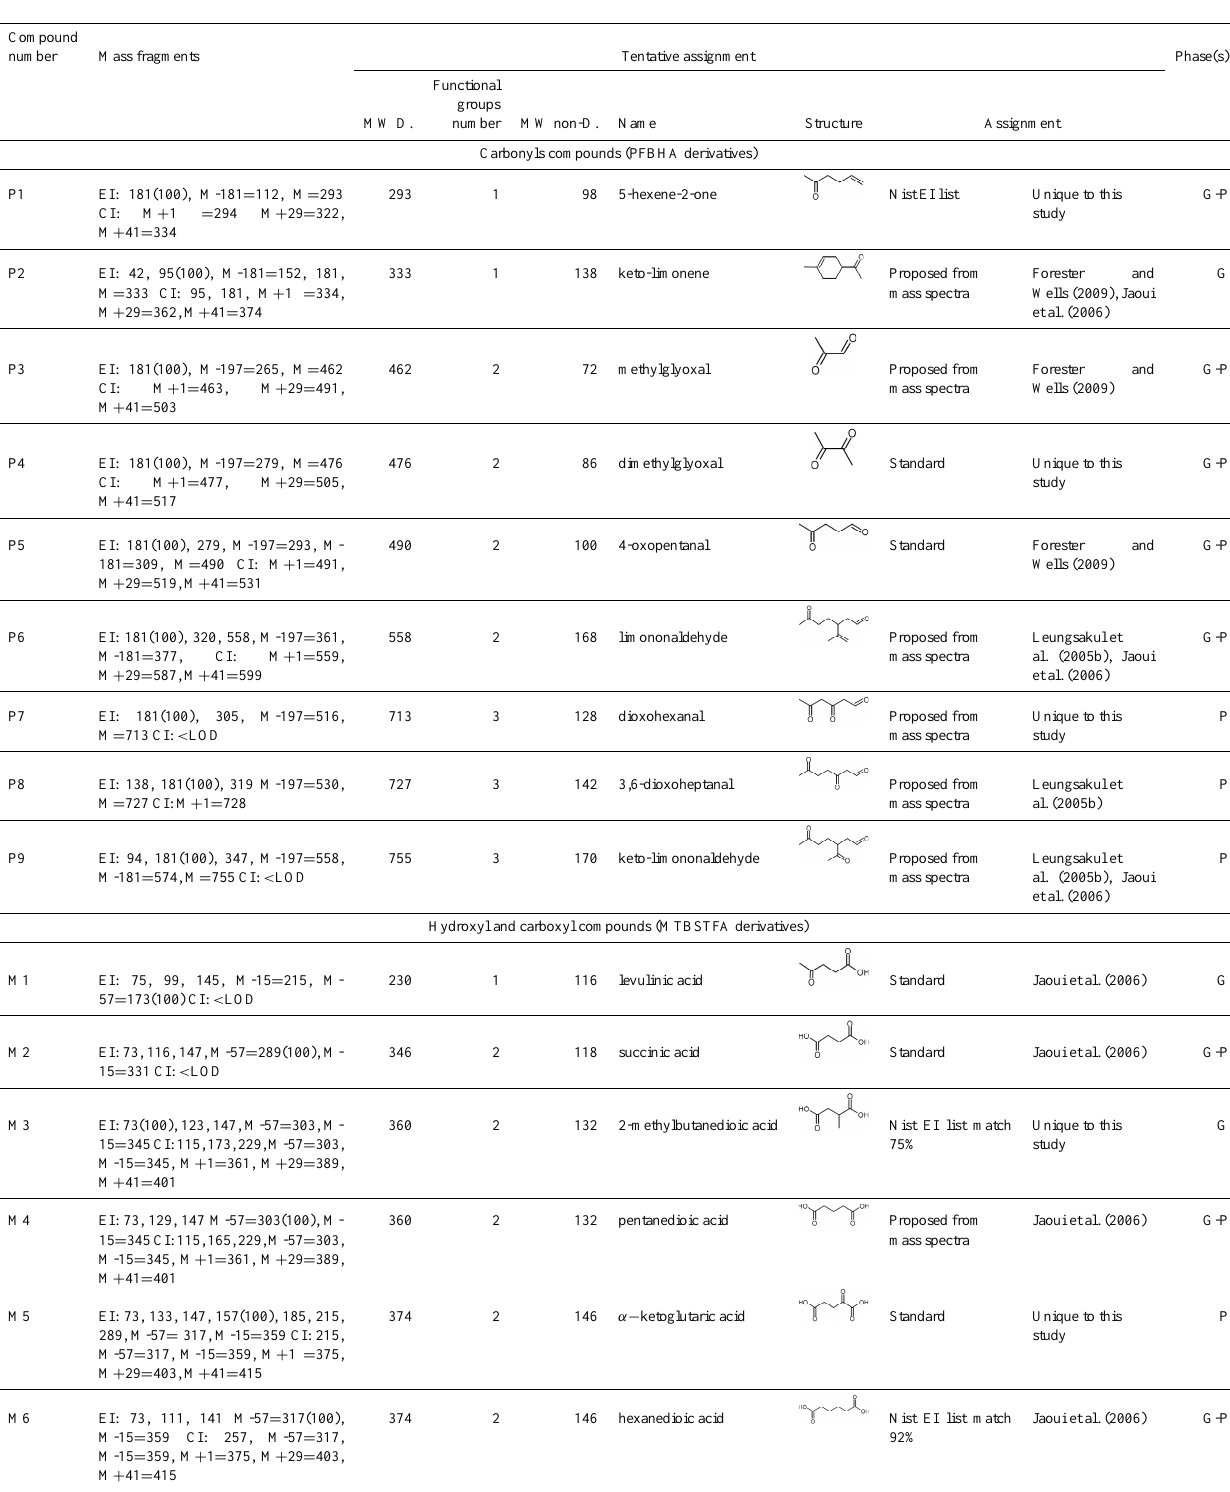
Table 7. Tentative or positive identification for observed carbonyl compounds, organic acids and hydroxyls compounds from limonene ozonolysis experiment. MW D.: molecular weight of the derivatised compound. MW non-D.: molecular weight of the non-derivatised compound. LOD: limit of detection. G: detected in the gas phase. P: detected in the particulate phase.